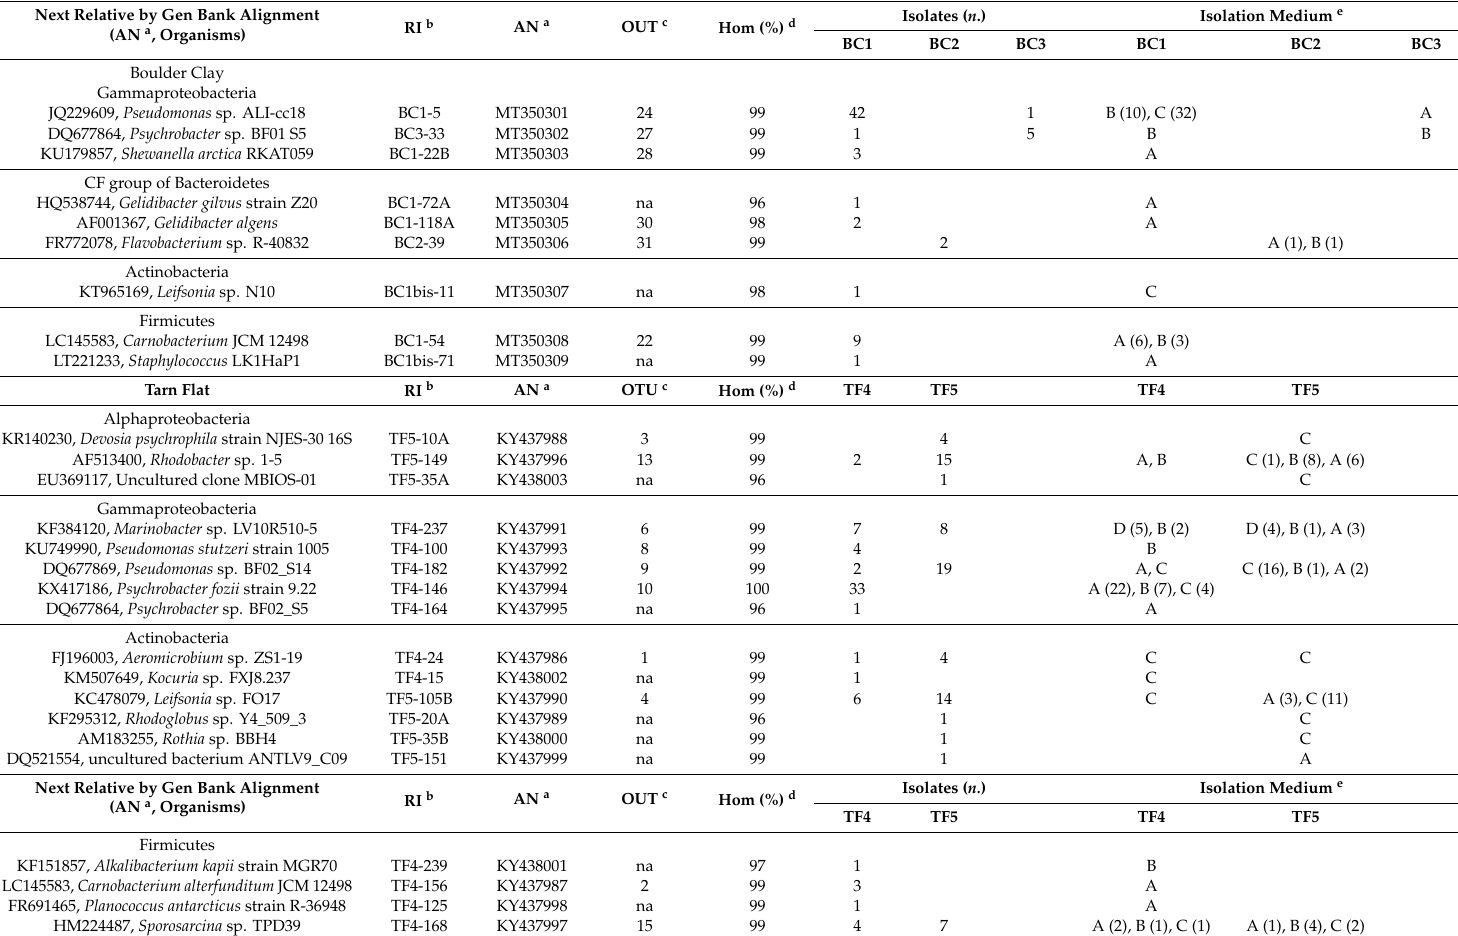
Table 2. 16S rRNA gene sequence a ffi liation to their closet phylogenetic neighbours of bacterial isolates from Antarctic lake brines. Numbers in brackets indicate the number of isolates per medium. Unidentified isolates are not